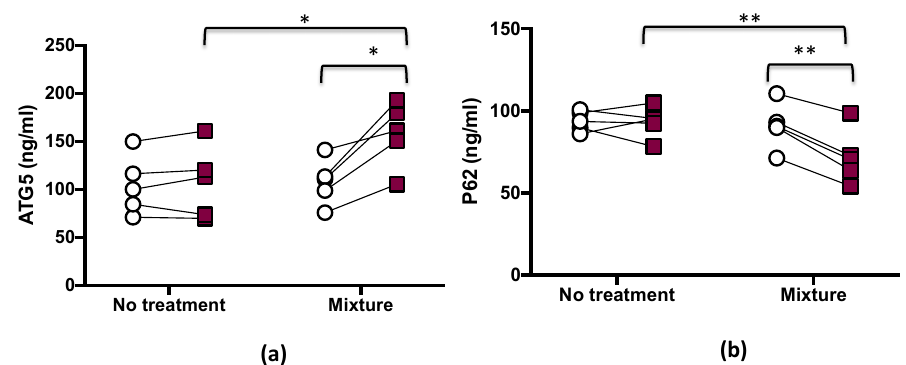
Figure 4. Serum ATG5 ( a ) and p62 ( b ) before (T0) and 1 month (T30 days) after mixture intake ( n = 5) or no-treatment period ( n = 5) in athletes. Data are expressed as mean ± SD. * p < 0.05, ** p < 0.01.